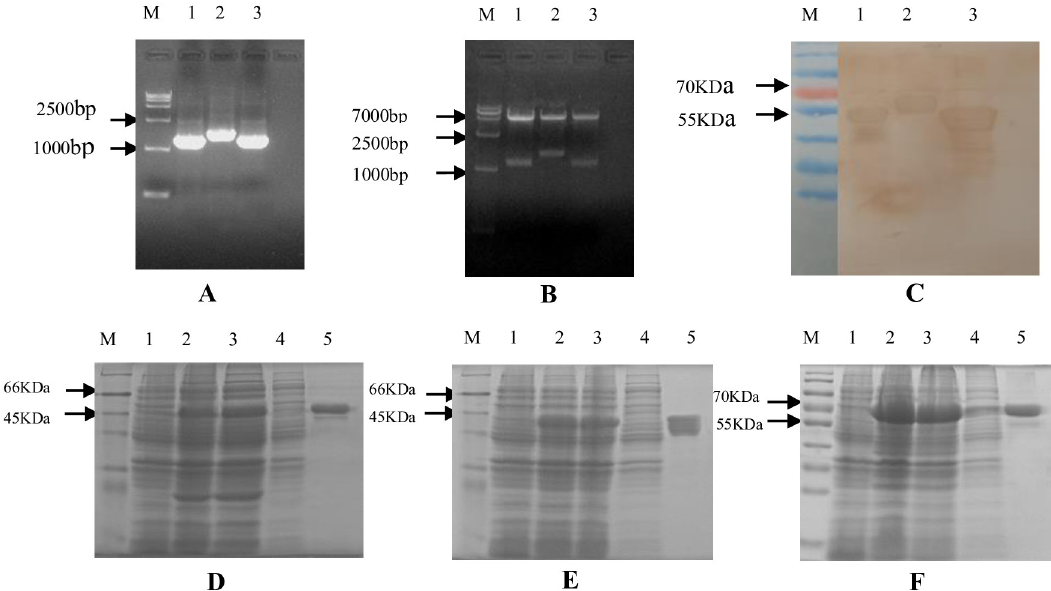
Fig 1. Preparation and identification of three PspA proteins. (A and B) Identification results obtained by PCR (A) and enzyme digestion (B) of three PspA expression plasmids. M: DNA Marker; Lane 1: PspA1 protein; Lane 2: PspA3 protein; Lane 3: PspA2 protein. (D–F) SDS-PAGE results for recombinant proteins PspA1, PspA2, and PspA3 in sequence. M: Marker; Lane 1: empty vector control; Lane 2: recombinant protein 4 h after induction with IPTG; Lane 3: supernatant of recombinant protein after sonication; Lane 4: precipitation of recombinant protein after sonication; Lane 5: supernatant of recombinant protein after purification. (C) Western blot analysis results of PspA proteins. M: Marker; Lane 1: recombinant protein PspA1; Lane 2: recombinant protein PspA3; Lane 3: recombinant protein PspA2.